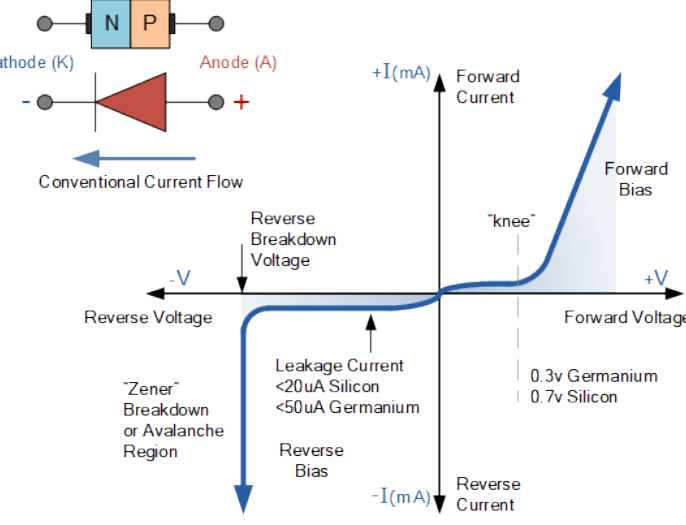
Fig. 4 IV curve of PN junction.